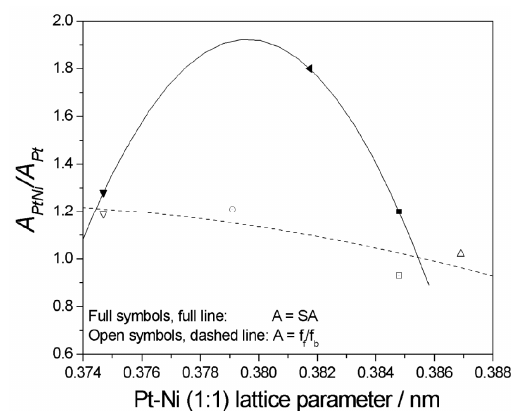
Figure 1. Dependence of the Pt-Ni to Pt electrochemically active surface area ( ECSA Pt-Ni /ECSA Pt ) ( a ); MOR specific activity ( SA Pt-Ni /SA Pt ) ( b ); MOR mass activity ( MA Pt-Ni /MA Pt ) ( c ) and ( I f /I bPt-Ni /I f /I bPt ) ( d ) ratios in acid media on Ni content in Pt-Ni catalysts with various alloying degrees by different datasets; Histogram of ( A PtNi /A Pt ) <1 /( A PtNi /A Pt ) Tot ratios (A = ECSA, SA, MA and I f /I b ), where ( A PtNi /A Pt ) Tot1 and ( A PtNi /A Pt ) <1 are the number of values of the ratio total and lower than 1, respectively in ( e ). Symbols in Figure 1a–d: (+) Shen et al. [20]; ( ▲ ) Zhou et al. [21]; ( ◄ )Agrawal et al. [22]; ( ■ ) Wang et al. [37]; ( ● ) Jiang et al. [38]; ( ▼ ) Nassr et al. [39]; ( ♦ ) Hao et al. [40]; ( ► ) Wang et al. [41]; (*) Luo et al. [42]; (X) Hu et al. [43]; (O) Zhou et al. [44].